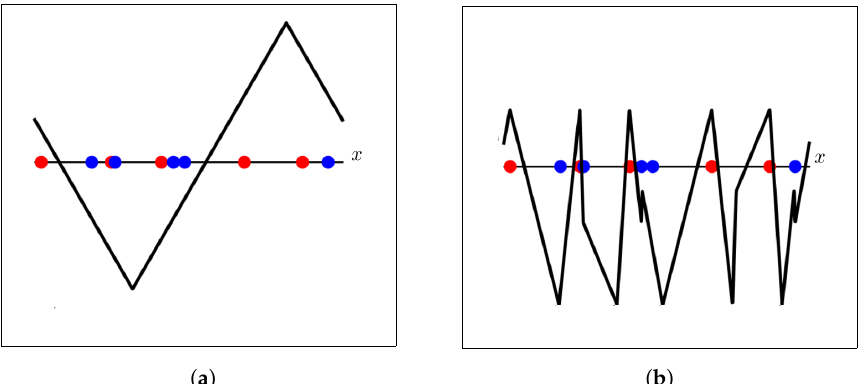
Figure 2. Example illustrating the benefits of the triangle wave kernel. ( a ) The SVM with the triangle wave in the primal form cannot learn more than two thresholds; therefore, some training points in this toy dataset are misclassified. ( b ) The SVM with the triangle wave kernel can learn an arbitrary number of thresholds, classifying every training point in this toy dataset